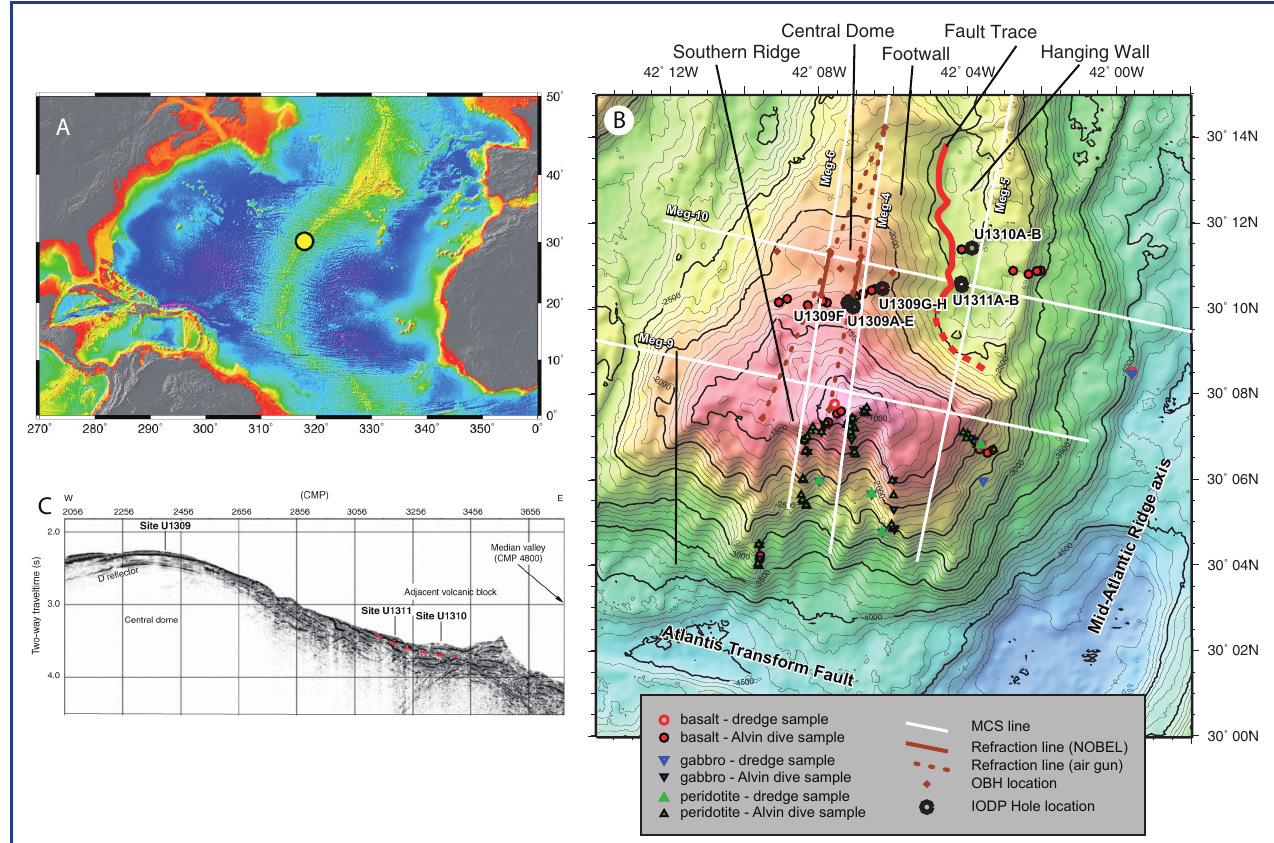
Figure 1. [A] Location of Expeditions 304 and 305. [B] Base map of Atlantis Massif showing prior geological and geophysical data coverage and location of drilling sites. Seismic reflection and refraction lines and seafloor mapping and sampling sites are shown. MCS = multi-channel seismic, OBH = ocean-bottom hydrophone. [C] MCS line Meg-10, stacked section showing D reflector and possible continuation of the detachment fault beneath the hanging wall (dashed red